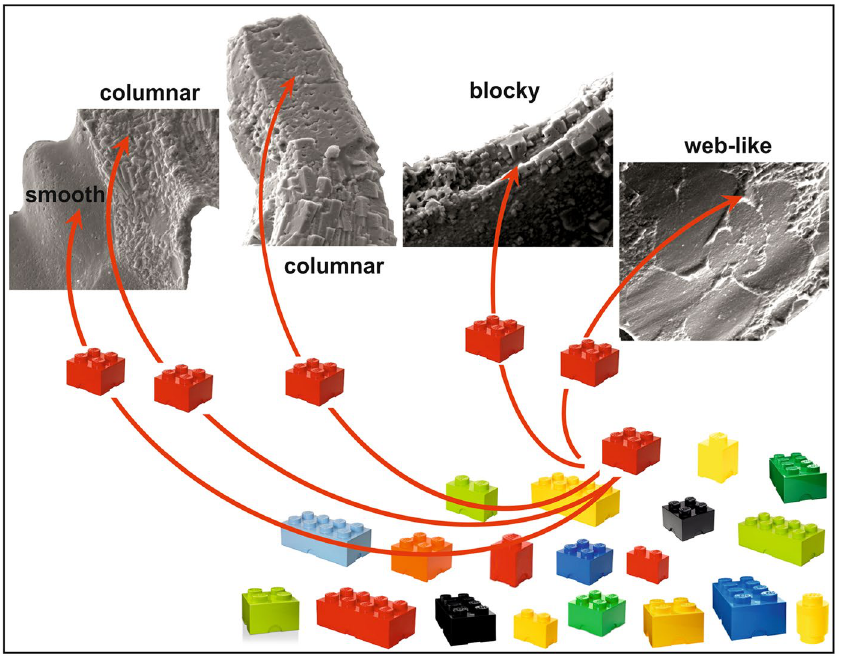
Figure 7. Diagenesis replicates original data: diagenetic (columnar, blocky and web-like crystal microtexture) and primary (smooth surface area) crystals share exactly the same chemical composition (red colour) and cell parameters (4-stud brick) within the large set of apatite compounds (represented by different colours and geometric